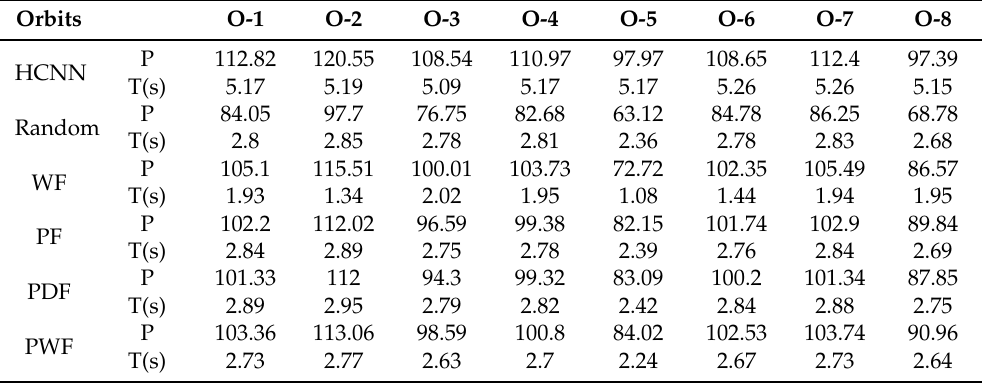
Table 8. Experimental results for the single-orbit scenarios with 25 tasks. Orbits HCNN Random